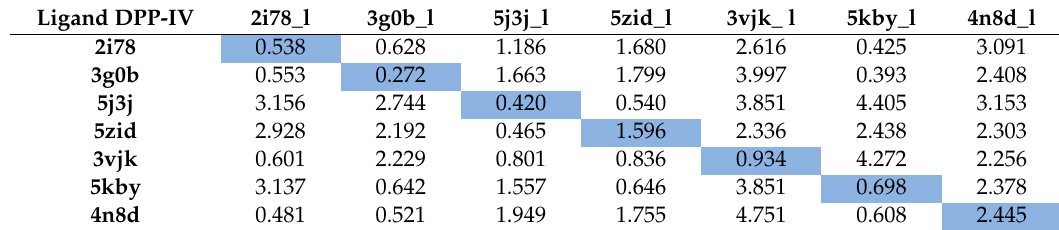
Table 6. The result of RMSD values of re-docking and cross-docking